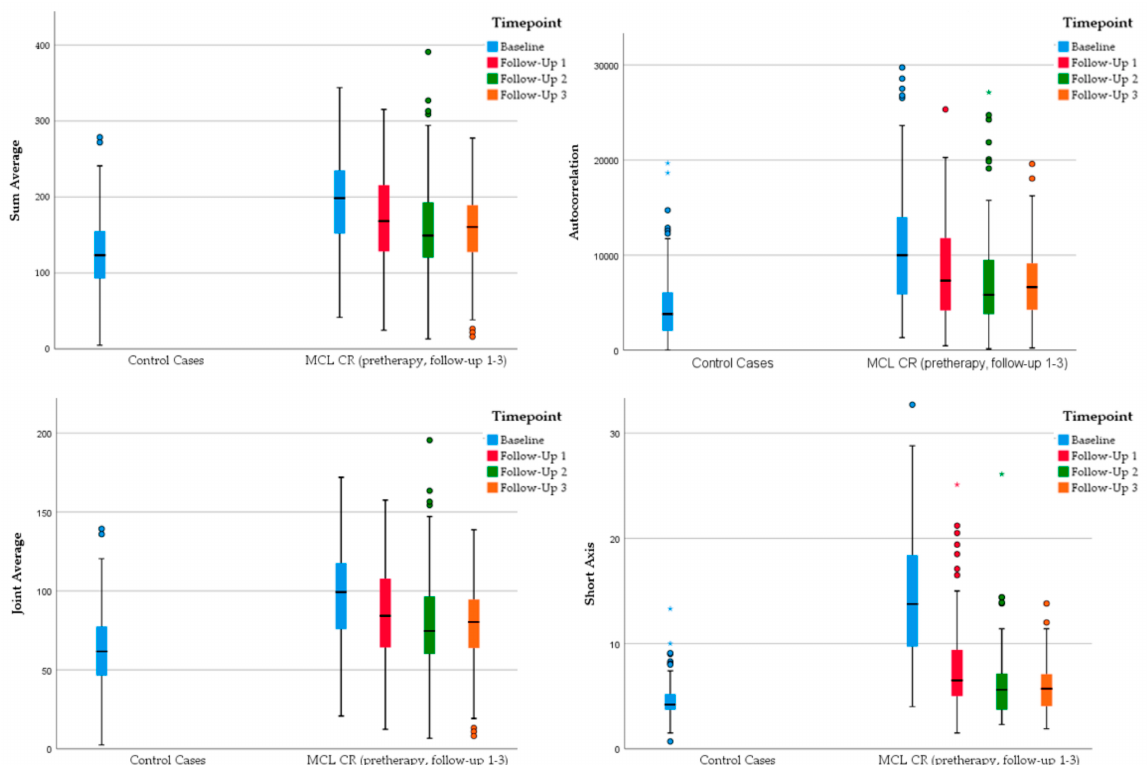
Figure 4. Grouped boxplots representing changes in specific radiomic parameters of MCL patients in complete remission (MCL CR) with no longer significant differences to the control cases with normal lymph nodes at the follow-up imaging at 6 and 12 months, respectively. * represents an outlier defined as a data point that is located outside 1.5 times the interquartile range above the upper quartile or below the lower